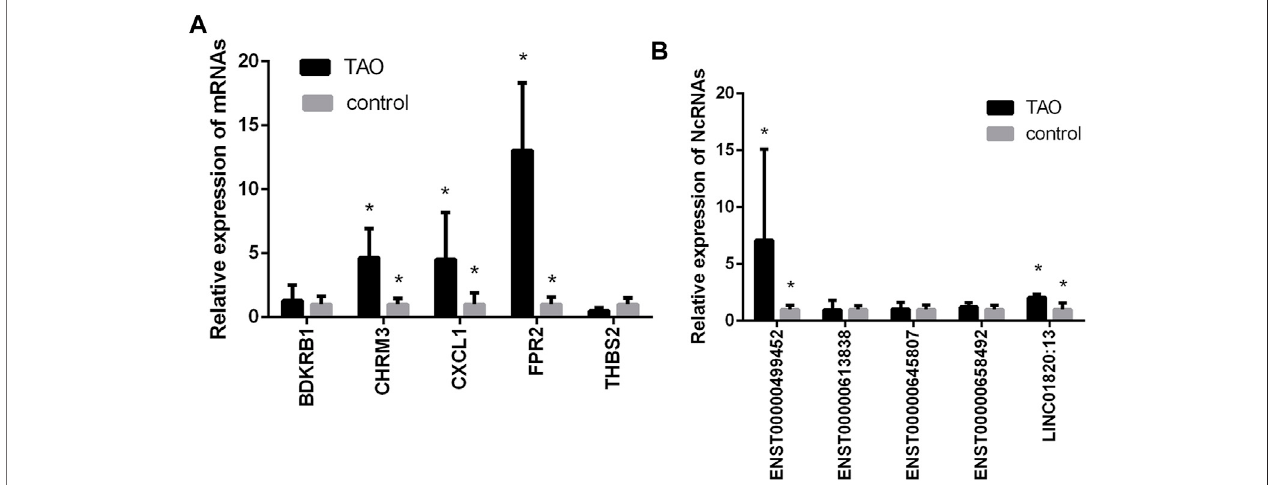
FIGURE 5 | Validation of the expression levels of mRNAs and lncRNAs/circRNAs in the GO groups and control groups. (A) mRNA expression levels as veri fi ed by qPCR. (B) Expression levels of lncRNAs/circRNAs as veri fi ed by qPCR. (*, p < 0.05).